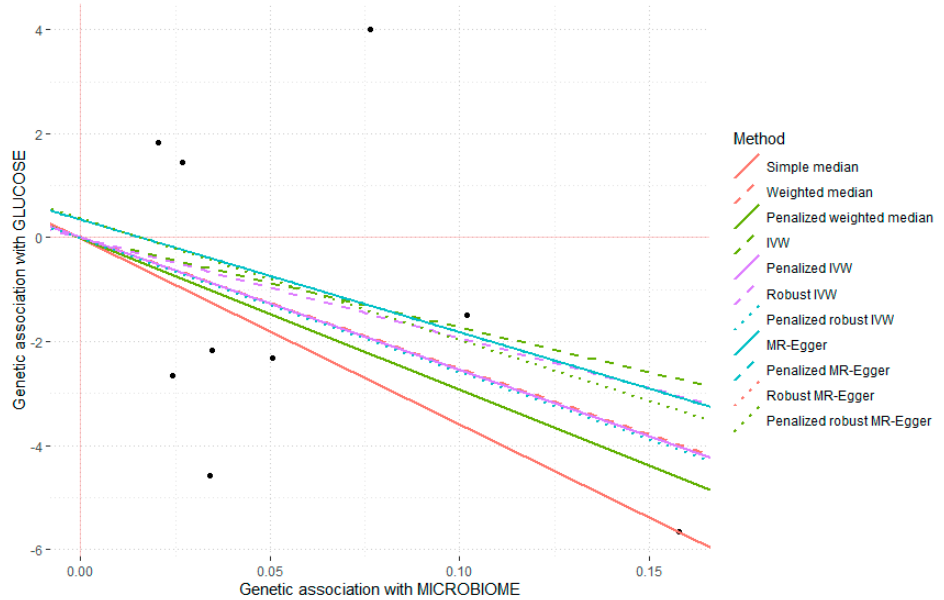
Figure 2. Scatter plot and regression lines of genetic associations with gut microbiome (nine SNPs) against the genetic association with fasting plasma glucose. The slope of the lines represents the so-called “causal” association, and each method has a different line. SNPs: Single nucleotide polymorphisms.